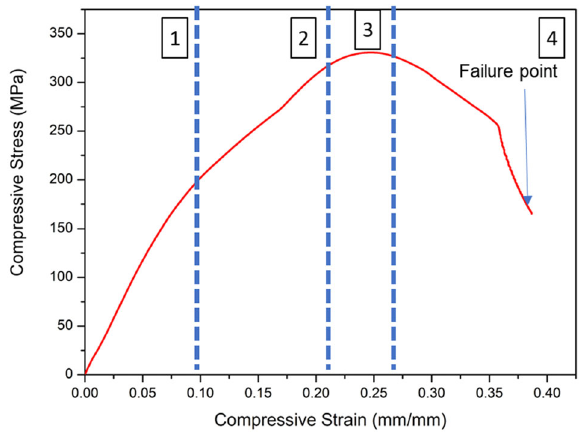
Fig. 2 A Typical compressive stress versus compressive strain of the Ti-Nb-Sn/Mg alloy with four different deformation